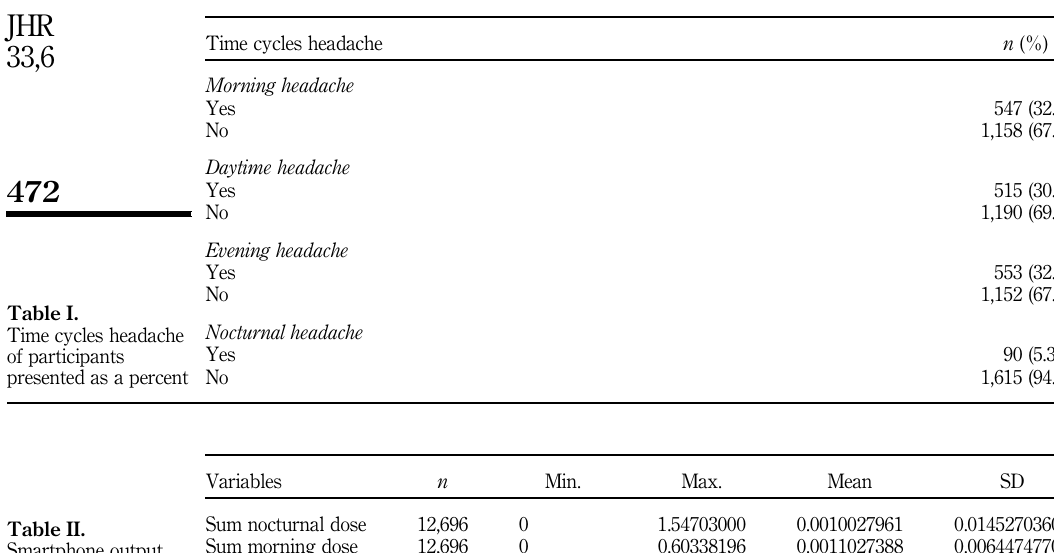
Table II. Smartphone output power (SOP) by time cycles and a daily dose of SOP